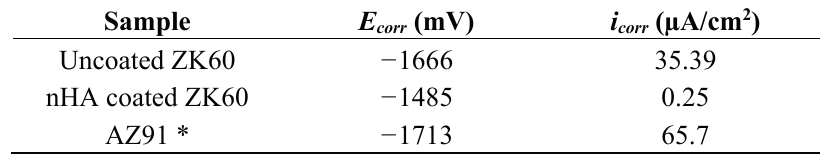
Figure 4. Potentiodynamic polarization curves of uncoated and nHA coated ZK60 samples. Table 1. Electrochemical data extracted from the polarization